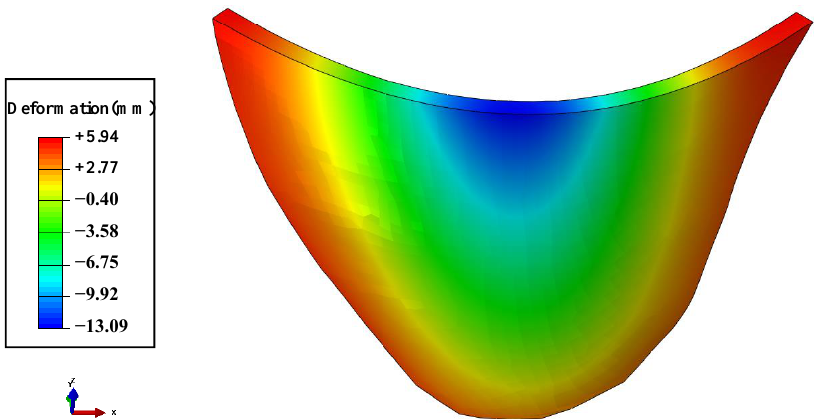
Figure 28. Numerical calculation results of radial deformation field of the dam influenced by valley contraction.